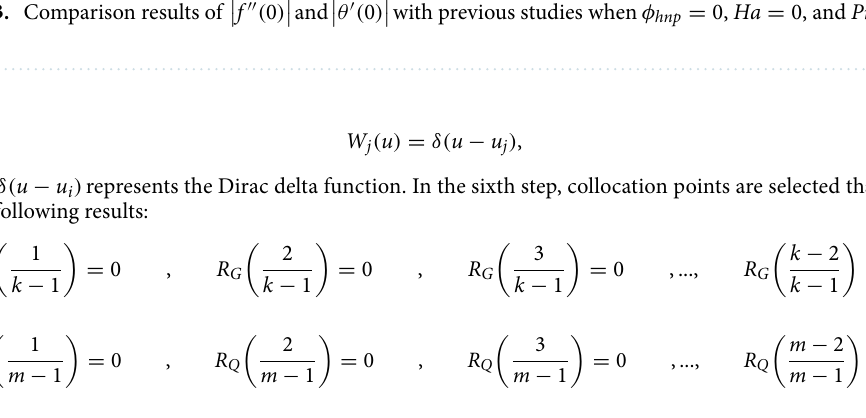
Table 3. Comparison results